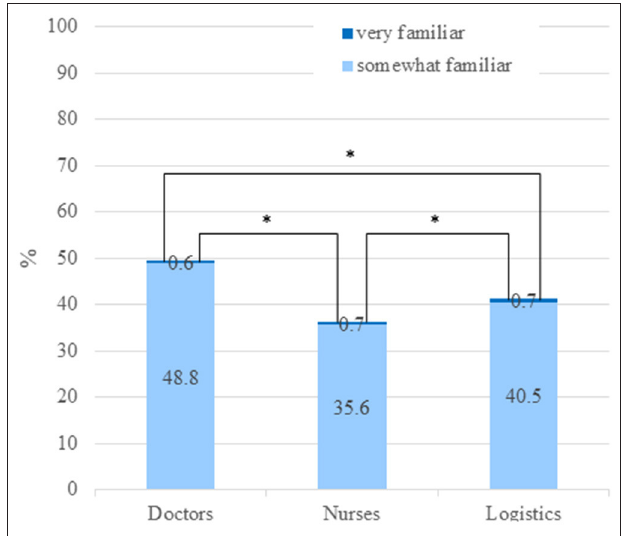
FIGURE 3 | Familiarity with disaster response teams. * p < 0.001. Chart showing response to Question